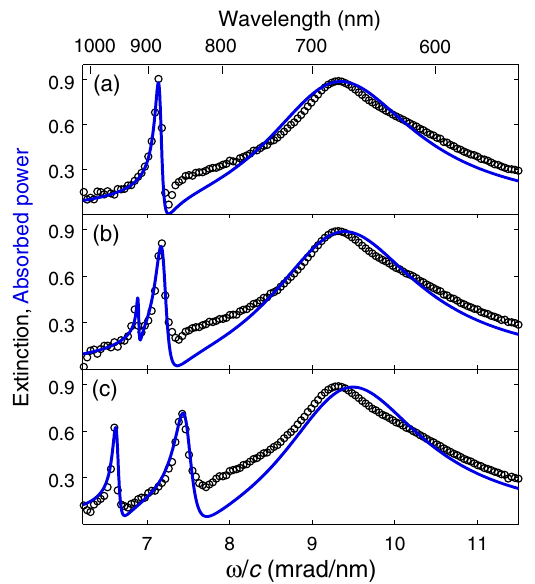
FIG. 4. The black open circles are cuts of the measured extinction spectra shown in Fig. 1 at three values of k k : 0 : 68 mrad = nm . The blue solid curves represent the absorbed power in oscillator 1 of the coupled-oscillator model described in the text, with coupling and damping frequencies as given